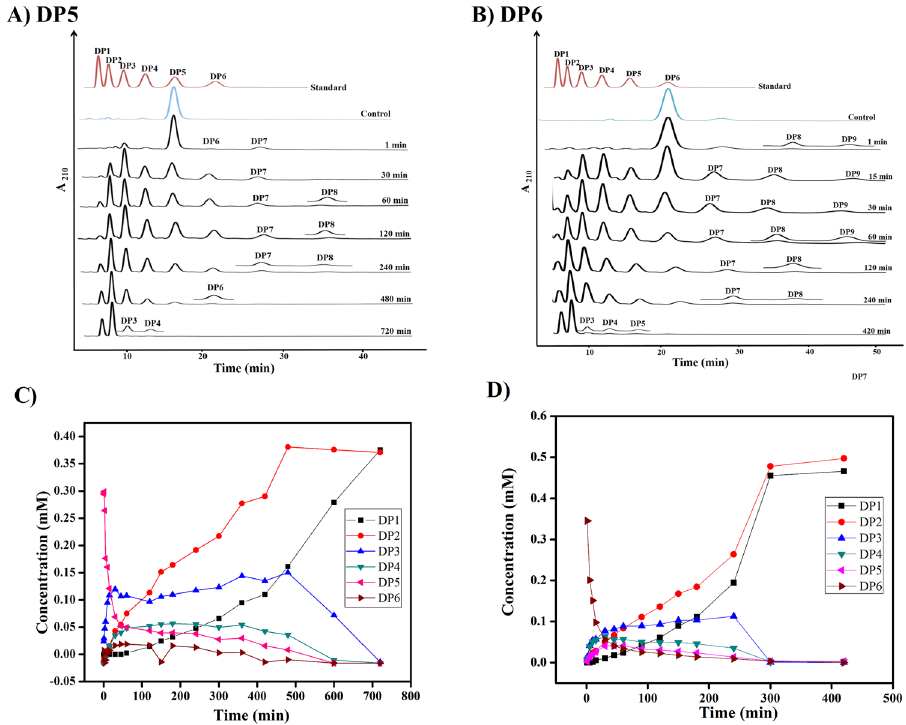
Figure 5. Time course hydrolysis and TG catalyzed by Ec Chi1 with DP5 and DP6. The reaction mixture products were analyzed by binary gradient HPLC. ( A and B ) HPLC profiles of reaction products from DP5 ( A ) and DP6 ( B ) substrates. The topmost profile shows a standard mixture of CHOS ranging from DP1 to DP6 ( A and B ). The other profiles show the reaction products from DP5 and DP6 substrates at the indicated incubation times. The inset shows a magnified view of the low-peak-area products. Control represents the substrate without Ec Chi1. ( C and D ) Overview of concentrations of CHOS products generated during reaction time courses with DP5 ( C ) and DP6 ( D ) substrates. Products were quantified from respective peak areas using standard calibration curves of CHOS ranging from DP1 to DP6.